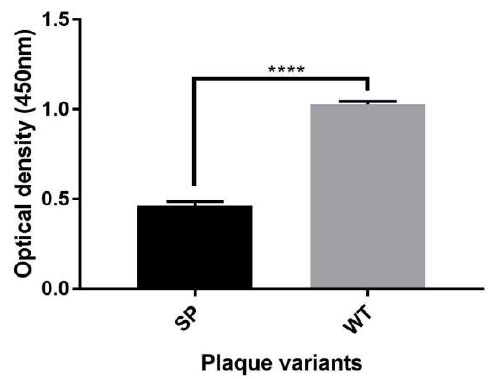
Figure 8. Viral-binding ability of EV-A71/SP was analyzed using ELISA performed in RD cells in comparison with the EV-A71/WT. The experiments were repeated three times and the average value is presented. Error bars indicate standard deviation of average. Statistical analysis, unpaired t -test, **** p < 0.0001.